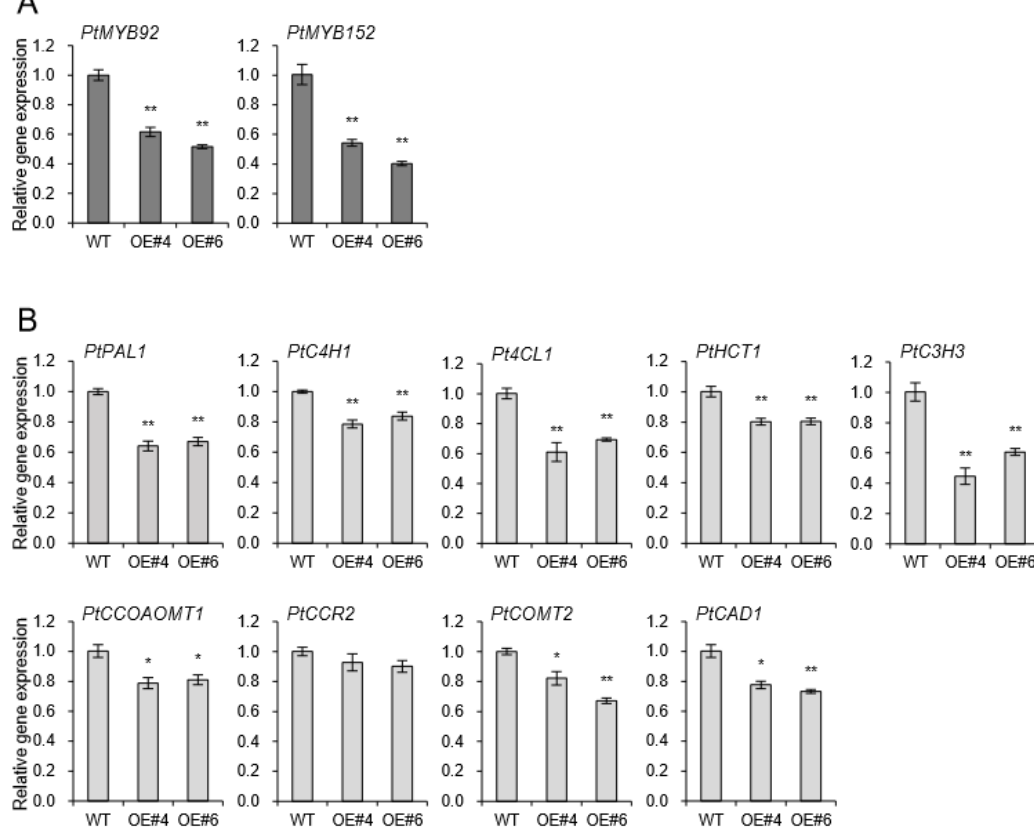
Figure 6. Genes involved in lignin biosynthesis were down-regulated in xylem of AtpPLAIIIα- OE lines. Expression levels of ( A ) two transcriptional activators, PtMYB92 and PtMYB152, and ( B ) several lignin biosynthetic genes. Each datum represents the average ± SE from three independent replicates at P < 0 . 05 (*) and P < 0 . 01 (**), respectively.